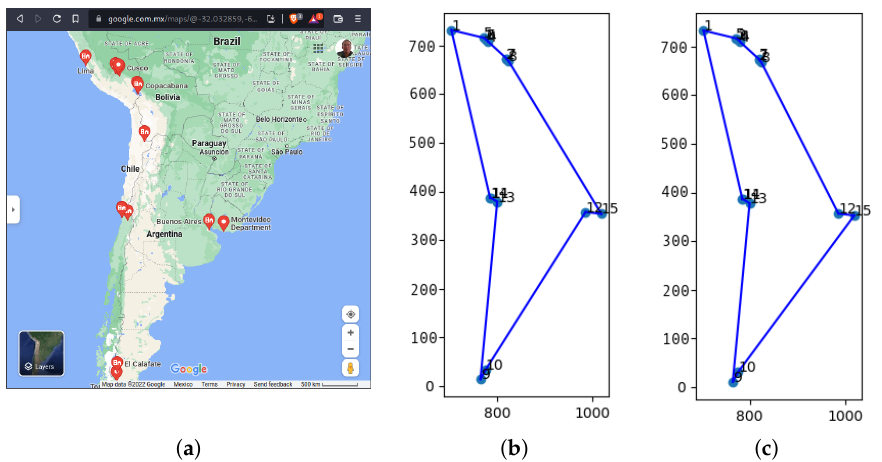
Figure 29. Map and solution of instance “ SouthAmerica.tsp ”. ( a ) Map [53]; ( b ) Solution; ( c ) Im- proved